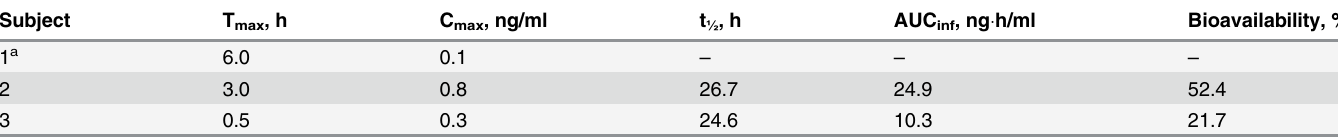
Table 4. Summary of pharmacokinetic parameters of s.c. BG00010 (50 μ